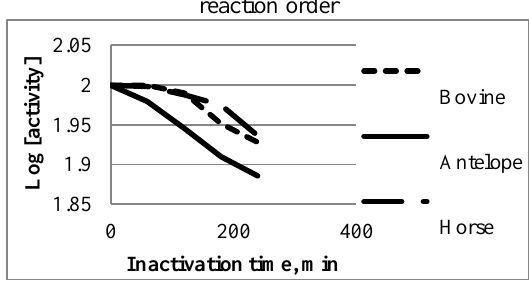
Figure 4. Hyaluronidases base inactivation reaction order